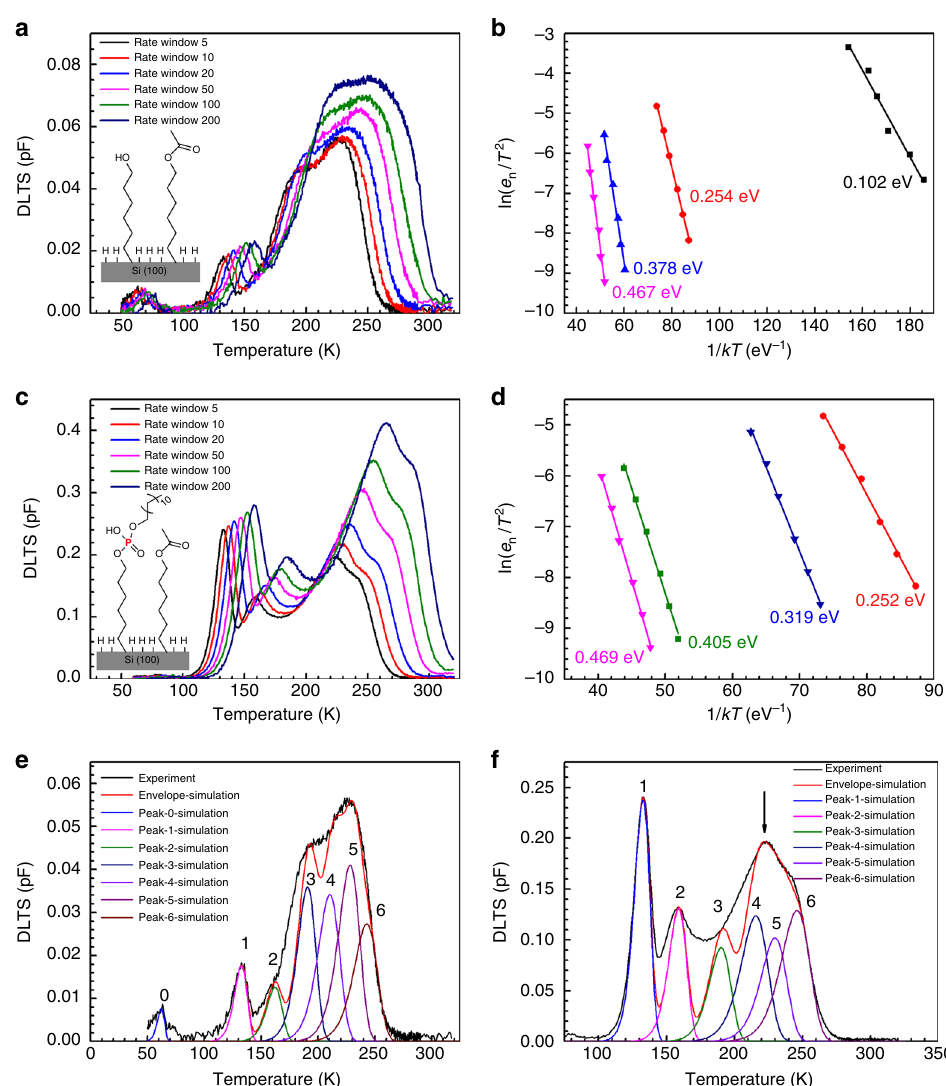
Fig. 5 Defect energy level analysis. DLTS spectra ( a ) and Arrhenius plot ( b ) of the n-type silicon control sample by annealing the chemically modi fi ed silicon surface as shown in the inset. DLTS spectra ( c ) and Arrhenius plot ( d ) of the SAMM-doped Si (the SAMM structure is displayed in the inset). DLTS simulations on the spectra (rate window of 5 s − 1 ) of the control sample ( e ) and the SAMM-doped Si ( f ). Note that the DLTS signals in e are much smaller in amplitude than those in